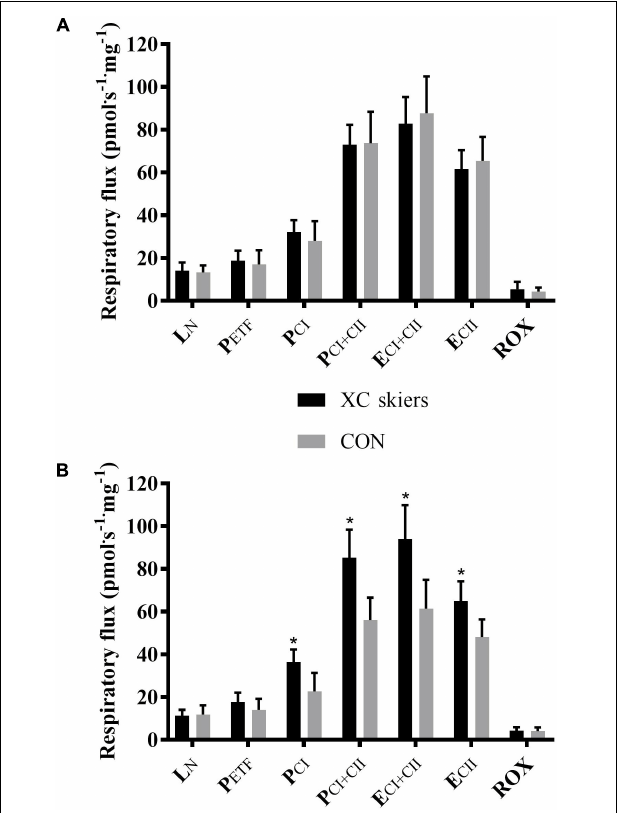
FIGURE 1 | Differences in respiratory flux in M. triceps brachii and M. vastus lateralis between elite cross-country skiers (XC skiers) and physically active controls (CON). (A) M. vastus lateralis and (B) M. triceps brachii. Respiratory flux expressed as mass-specific respiratory capacity (pmol · s − 1 · mg − 1 ) for leak respiration in absence of adenylates (L N ), fatty acid oxidative capacity (P ETF ), complex I respiration (P CI ), complex I and II respiration combined (P CI + CII ), electron transfer system capacity (E CI + CII ), electron transfer system capacity of complex II alone (E CII ) and residual oxygen consumption (ROX). Data are displayed as means ± SD. ∗ Significant difference between groups ( P <